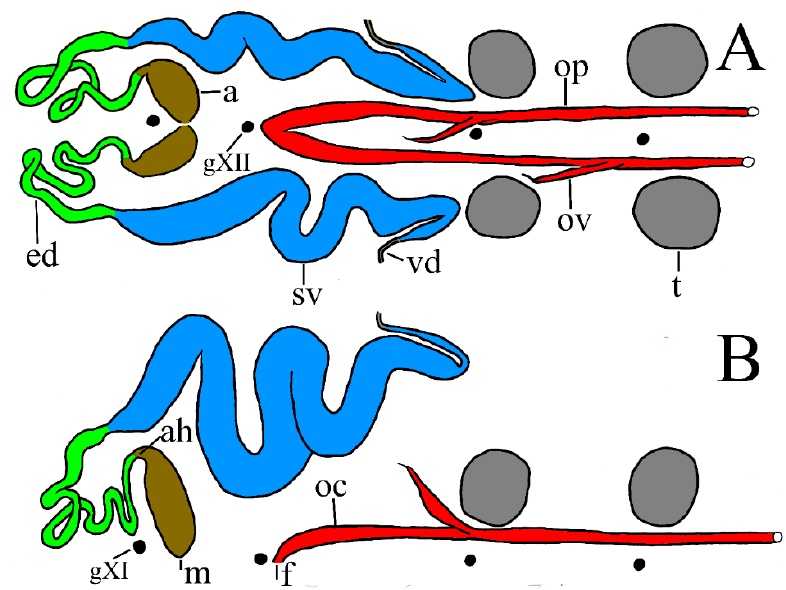
Figure 9. Scheme of the reproductive systems of P. parasitica, based on dissection of a mature specimen (PP-1, 36.5 mm) from Tyrrell County, NC. ( A ) Dorsal view. ( B ) Lateral view. Abbreviations: a, atrium; ah, atrial horn; ed, ejaculatory duct; f, female gonopore; gXI, ganglion XI; gXII, ganglion XII; m, male gonopore; oc, common ovisac; op, posterior arm of ovisac; ov, vertical arm of ovisac; sv, seminal vesicle; vd, vas deferens; t, testisac.